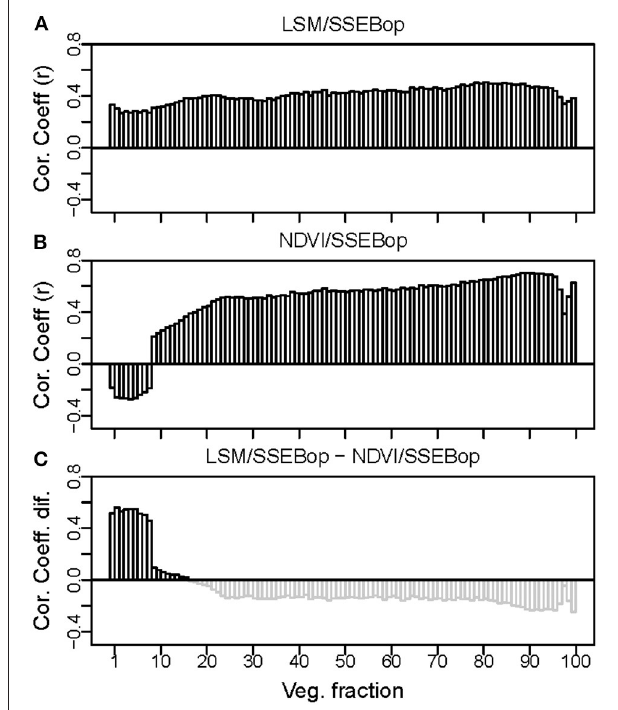
FIGURE 7 | The cross-correlation coefficient for the 2003–2016 as a function of vegetation fraction for (A) LSM ET/SSEBop ET, (B) NDVI/SSEBop ET, and (C) the difference in correlation between LSM ET/SSEBop ET and NDVI/SSEBop